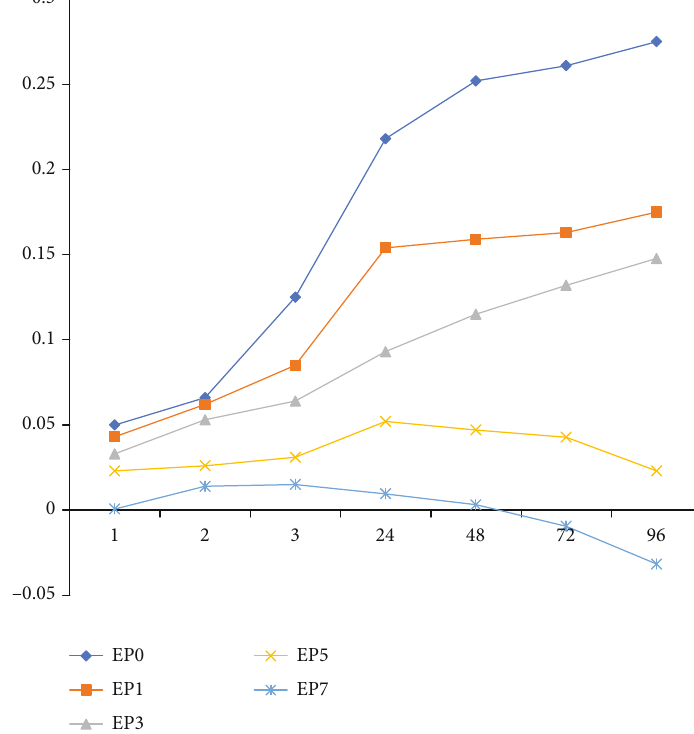
SO , of uncoated and coated GS. 2 4